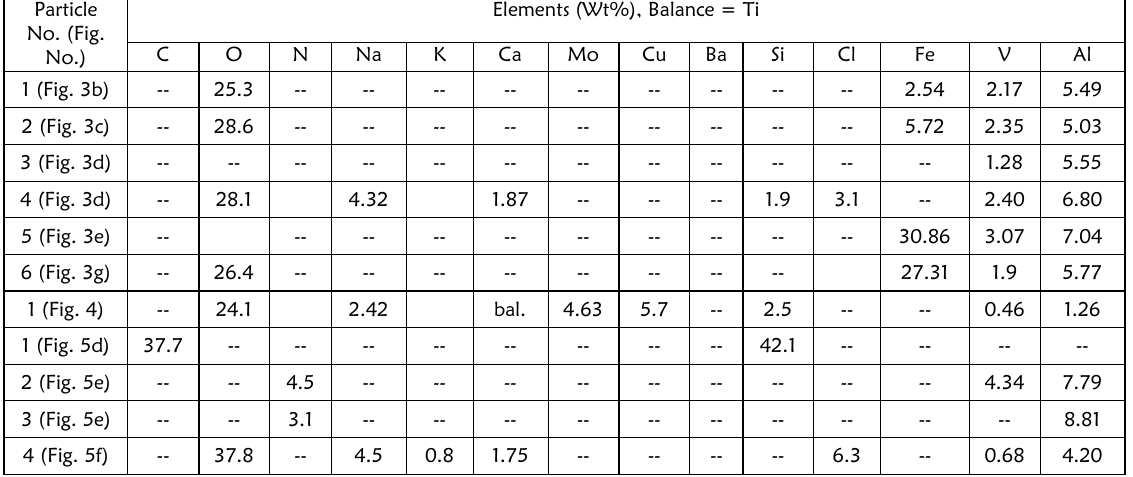
Table 3: EDS analysis results on various phases as found in fractographs and microstructures